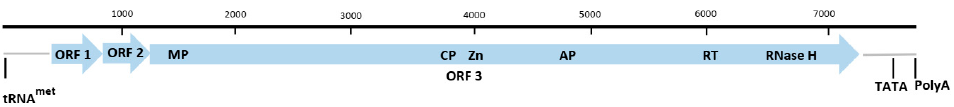
(DbBV) virus (DbBV) [17,28,83].